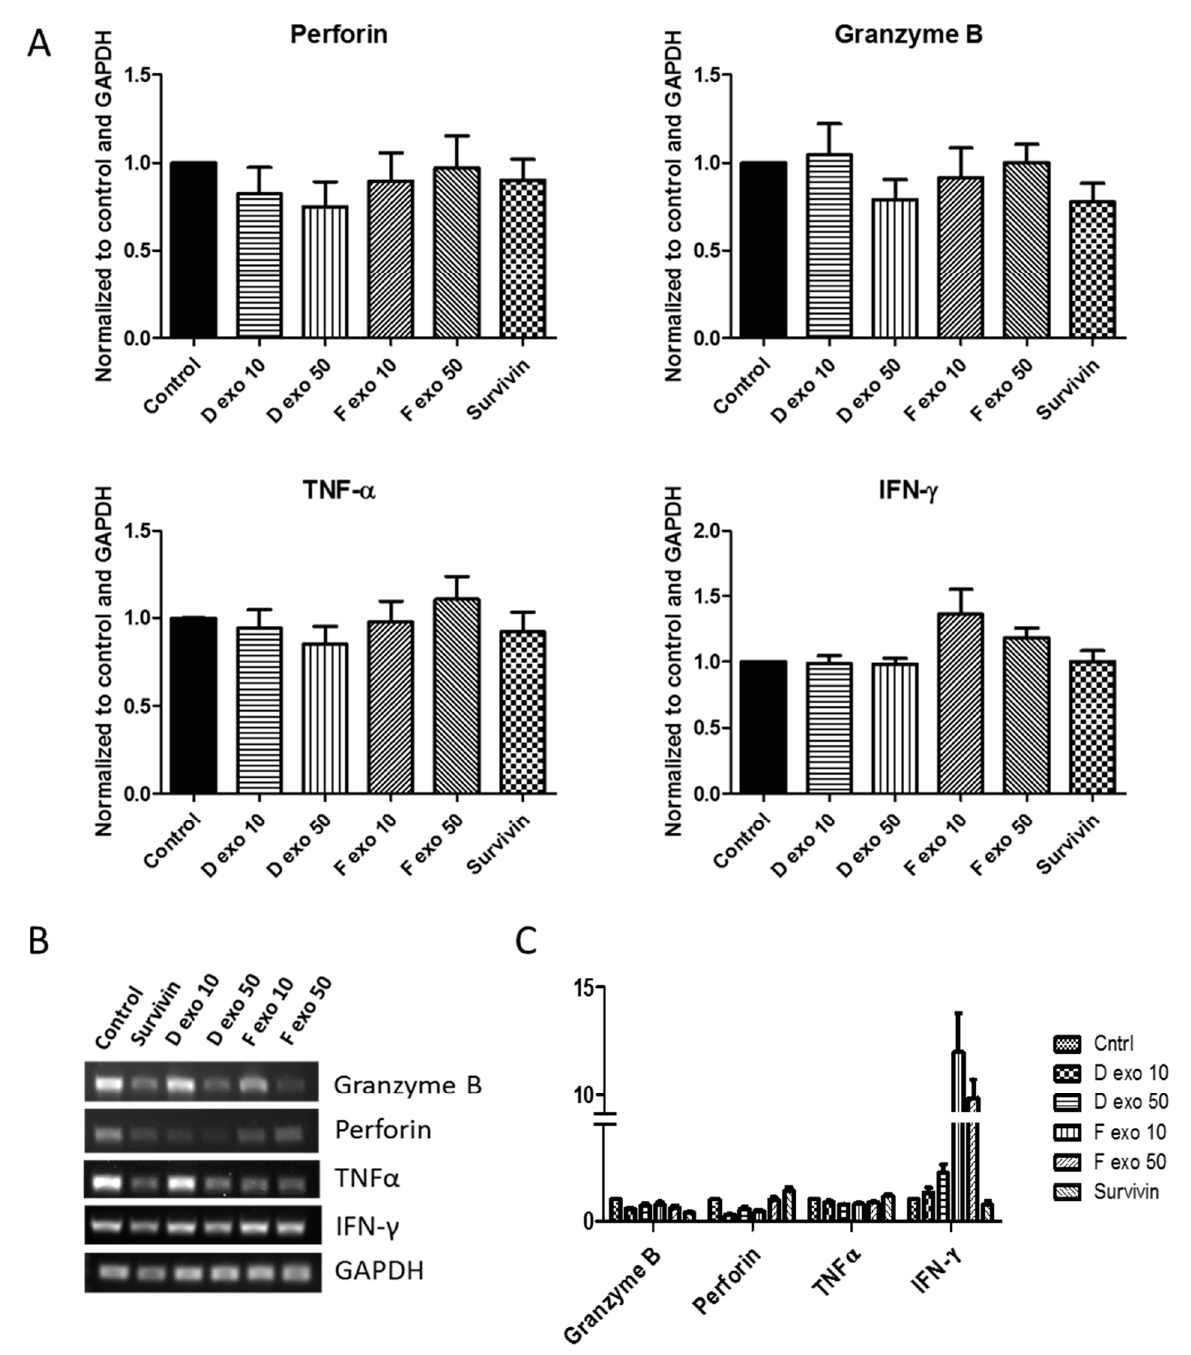
Figure 6. Lymphoma exosomes and survivin had no consistent effect on mRNA levels of NK cell cytokines and granules. ( A ) ImageJ density analysis of block RT-PCR bands did not show statistical significance in mRNA levels after 24 h treatment with lymphoma exosomes (10 µ g and 50 µ g) or survivin ( n = 5). ( B ) Block RT-PCR amplicon products from NK cells from one donor run on 1% agarose gel. ( C ) Gene expression ( ΔΔ Cq) was measured using real time qRT-PCR performed with a Bio-Rad CFX ( n = 5) and showed the greatest degree of change in IFN-g. As a test of functionality, we investigated the cytotoxic potential of NK cells by measuring their ability to lyse K562 target cells. NK cells were treated with 10 µg/mL recombi- nant survivin for 24 h prior to performing the lactate dehydrogenase release assay. NK effector cells were mixed with K562 target cells at various ratios, and the percentage of